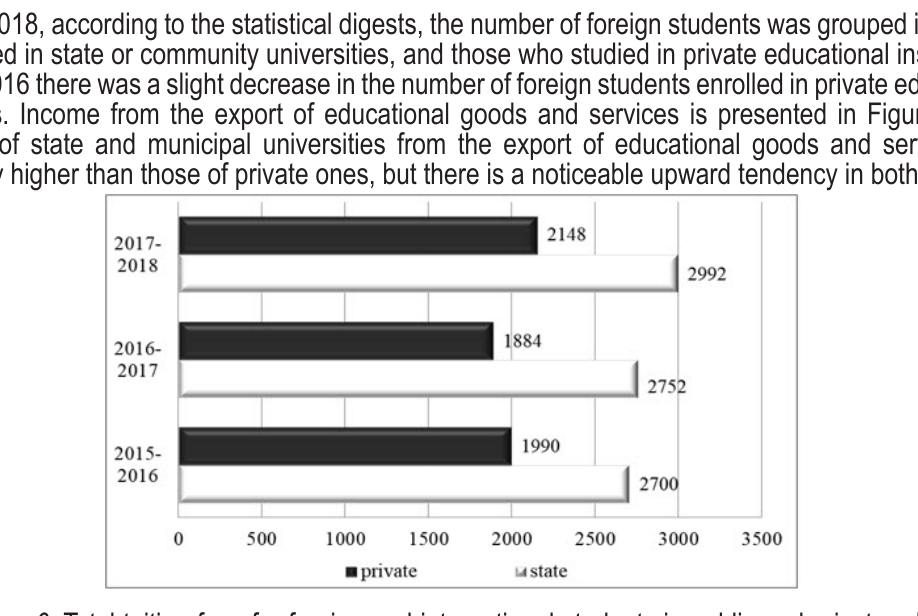
Figure 6. Total tuition fees for foreign and international students in public and private educational institutions of the Russian Federation, million